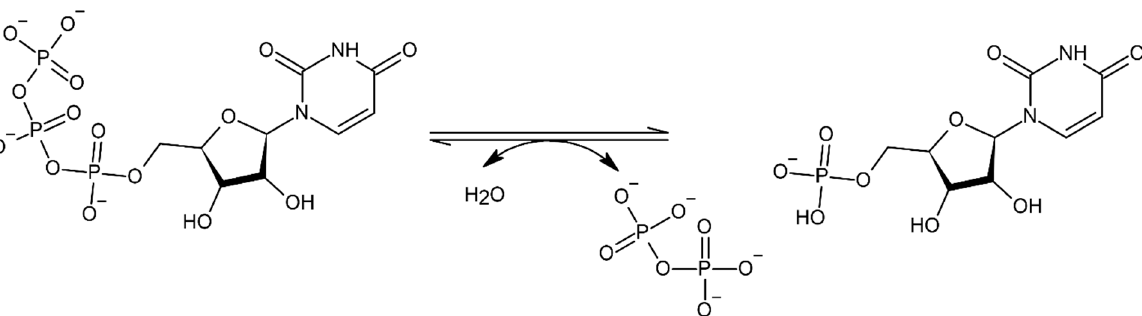
Figure 2. Chemical formation of ITP molecule.